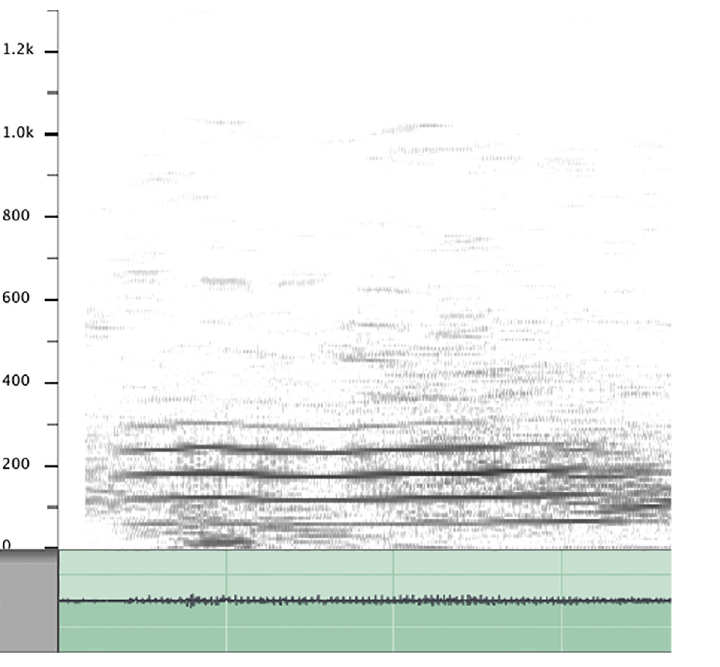
Fig 2. Spectrogram of